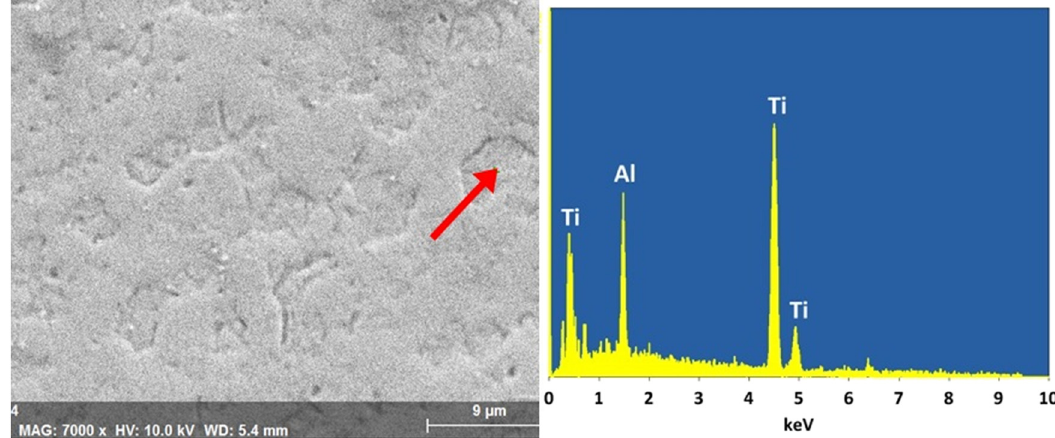
Figure 8: SEM - EDS analysis of friction stir spot welded joint: 2,000 rpm and 5 s dwell